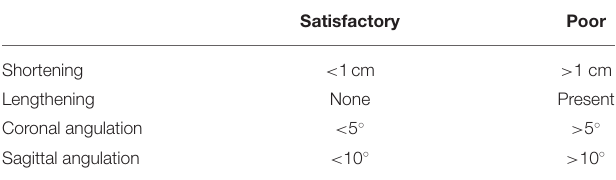
TABLE 1 | Beaty’s criteria (radiological outcome).